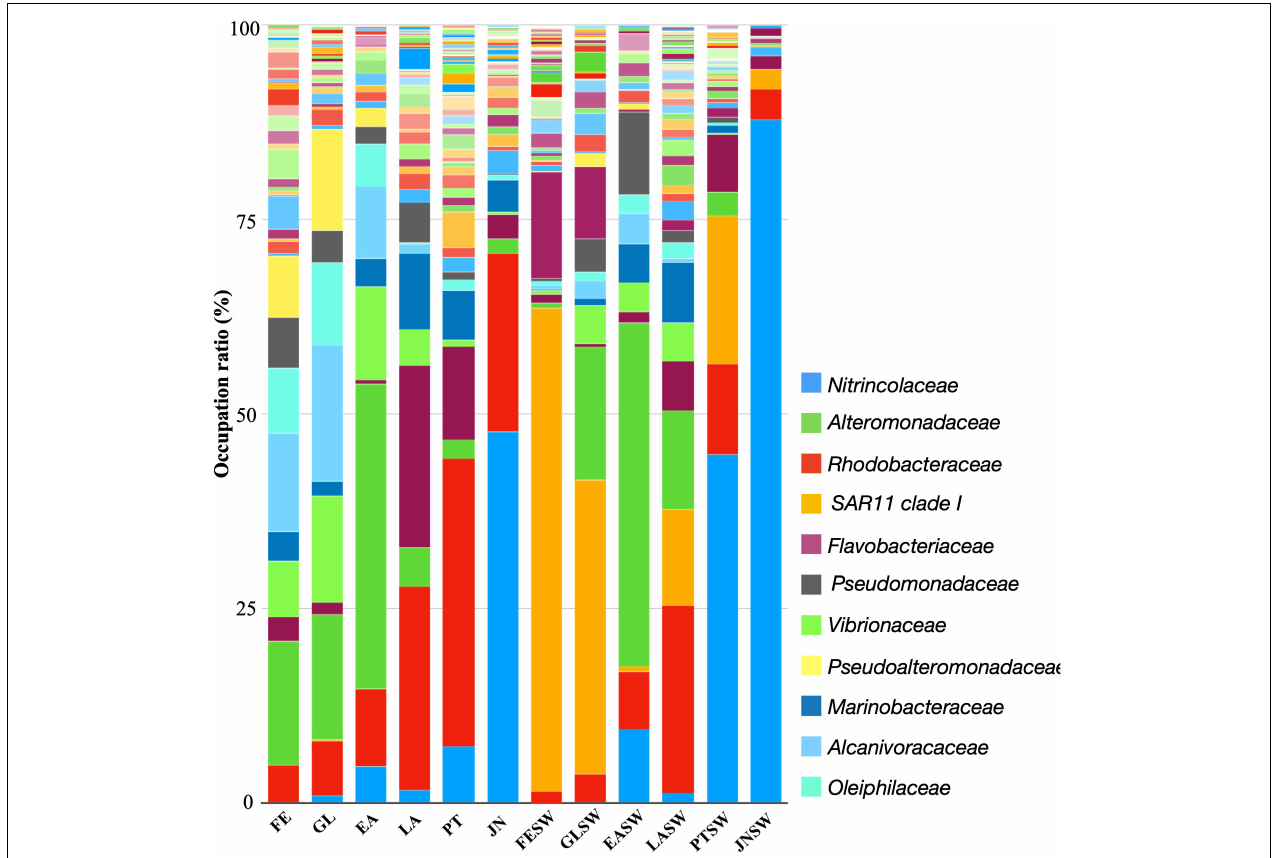
FIGURE 4 | Family-level taxonomic distribution among sea cucumber and seawater samples. Bars represent the relative percentage of each bacterial orders. FE, Fertilized Egg; GL, Gastrula; EA, Early Auricularia; LA, Late Auricularia; PT, Pentactula; JN, Juvenile; FESW, Kuma-shi seawater; GLSW, Gastrula rearing seawater; EASW, Early Auricularia rearing seawater; LASW, Late Auricularia rearing seawater; PTSW, Pentactula rearing seawater; JNSW, Juvenile rearing